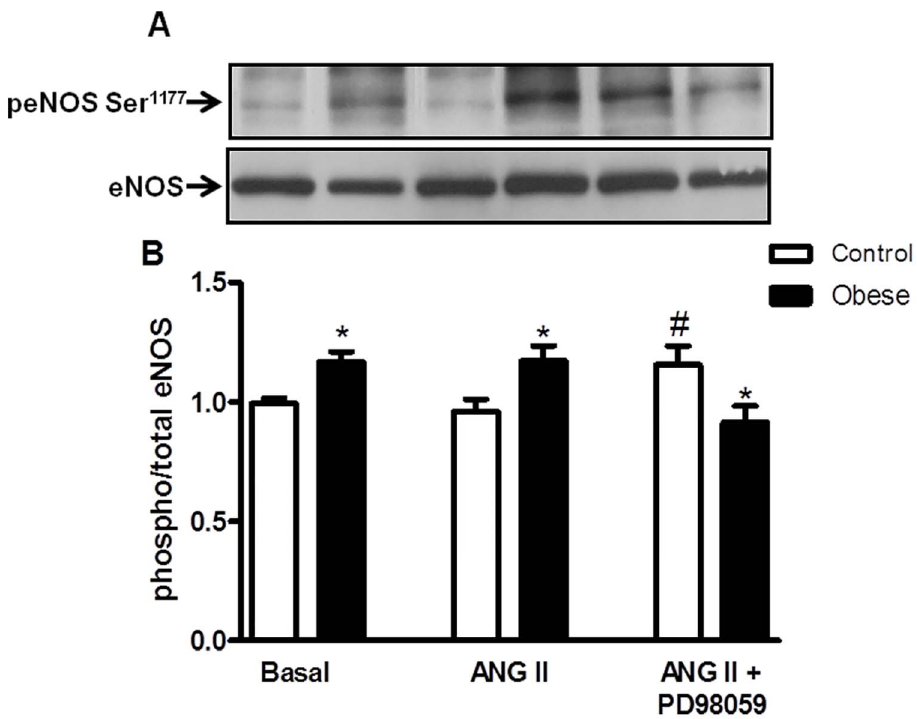
Figure 7. Effect of angiotensin II on eNOS phosphorylation in mesenteric arteries. Panels show densitometric analysis of the Western blots for eNOS protein expression in endothelium intact mesenteric arteries from control and monosodium glutamate-induced obese rats. Vessels from both groups were stimulated with ANG II (0.1 m mol/L) or vehicle for 10 min in the absence or in the presence of the ERK1/2 inhibitor PD98059 (1 m M, 30 min) and the phosphorylation of eNOS was examined. Total protein levels are shown as loading controls. Data are expressed as mean 6 SEM. *, P , 0.05 vs. Control, # , P , 0.05 vs. respective group in the presence of ANG II. N=5–6/group.